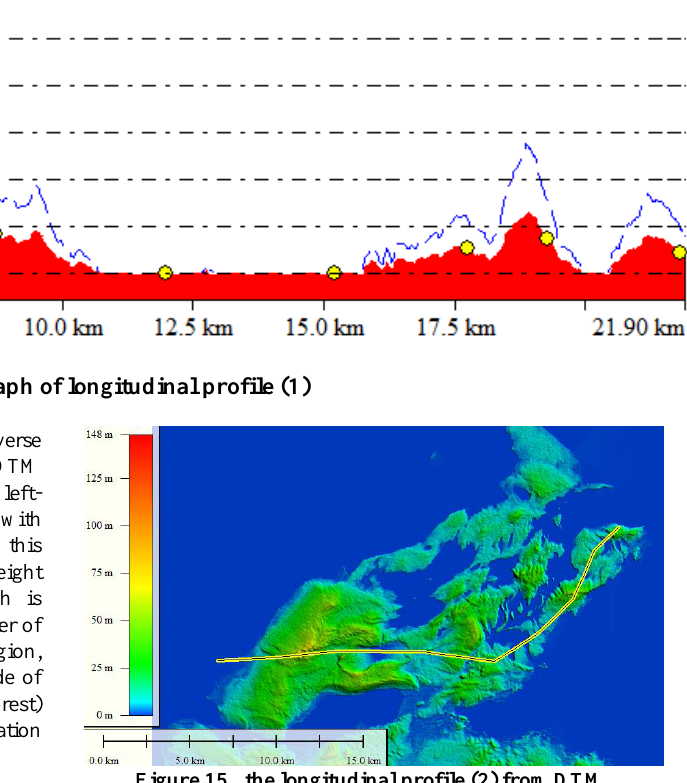
Figure 15. the longitudinal profile (2) from